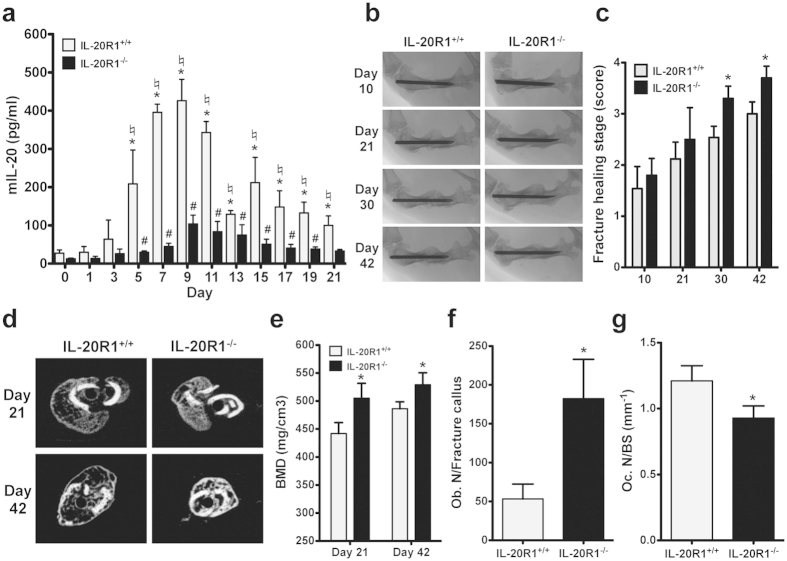
IL-20R1 deficiency increased osteoblast differentiation and promoted fracture healing by increasing BMD in the mouse fracture model.(a) Levels of IL-20 in serum from IL-20R1+/+ and IL-20R1−/− mice with bone fracture were analyzed at the indicated times during fracture healing. Values are means ± SD of 6 mice. Data are representative of three independent experiments. *P < 0.05 versus IL-20R1+/+ mice 0 day post-fracture. #P < 0.05 versus IL-20R1−/− mice 0 day post-fracture.♮P < 0.05 versus IL-20R1−/− mice post-fracture. (b) Radiographs of fractured right femurs from IL-20R1+/+ and IL-20R1−/− mice (n = 8/group). The radiographic time course is shown at the callus formation for the mice in each group. Data are representative of three independent experiments. (c) Radiological assessments on fracture healing by fracture healing stage score of the X-ray images from IL-20R1+/+ and IL-20R1−/− mice (n = 8/group). Data are representative of three independent experiments. (d) Representative figures of micro-CT analyses of the fracture callus of IL-20R1+/+ and IL-20R1−/− mice 21 and 42 days post-fracture (n = 8/group). Images of these individual slices were taken from the central region of each callus. Data are representative of three independent experiments. (e) BMD at the fracture line was assessed using micro-CT scans 21 and 42 days post-fracture (n = 8/group). Values are means ± SD. Data are representative of three independent experiments. *P < 0.05 versus IL-20R1+/+ mice. (f) ALP staining analysis and quantification of the number of osteoblasts in the fracture callus 21 days post-fracture (n = 8/group). Values are means ± SD of 3 frozen sections. Data are representative of three independent experiments. *P < 0.05 versus IL-20R1+/+ mice. (g) TRAP staining analysis and quantification of the number of osteoclasts in bone surface 21 days post-fracture (n = 8/group). Values are means ± SD of 3 frozen sections. Data are representative of three independent experiments. *P < 0.05 versus IL-20R1+/+ mice.